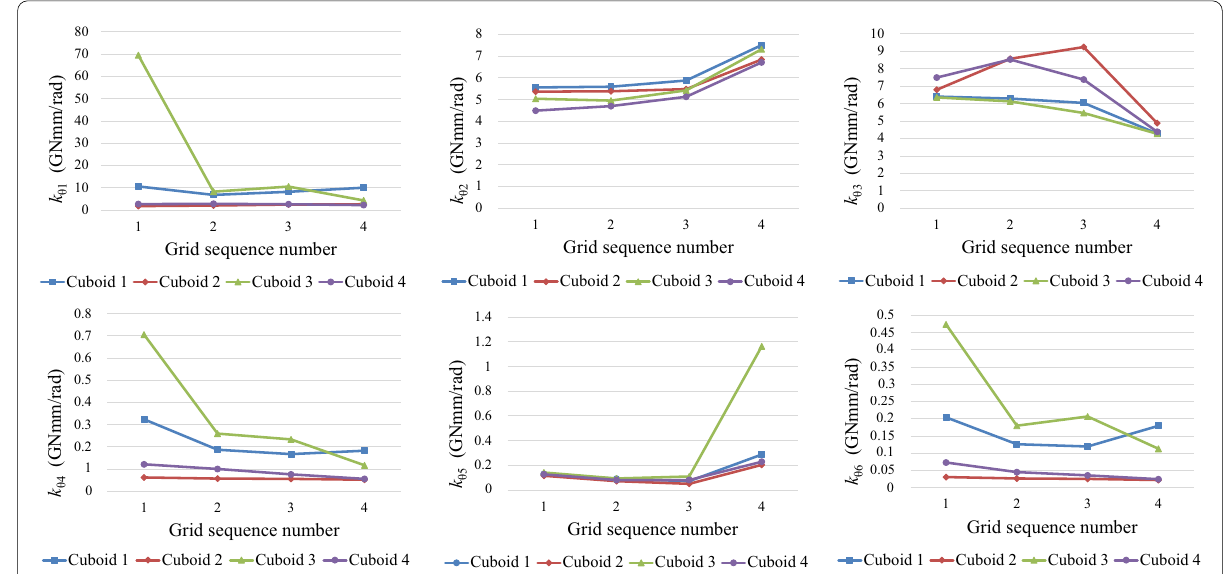
Figure 11 Joint stiffness in different 300 mm